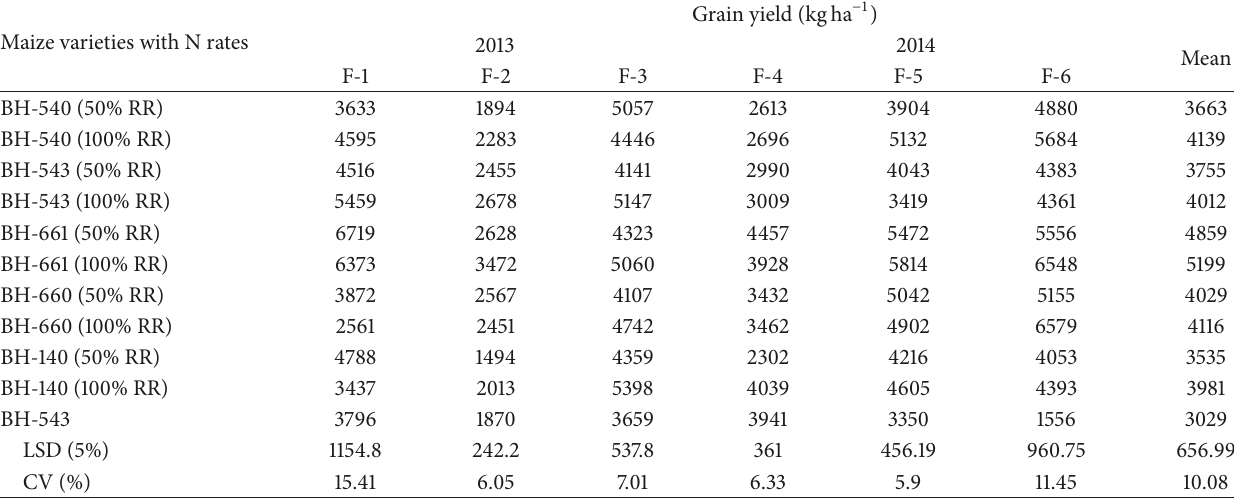
Table 7: Combination effects of varieties and nitrogen rate on mean grain yield and thousand seed weight of maize on farmer’s field around Bako Tibe, western